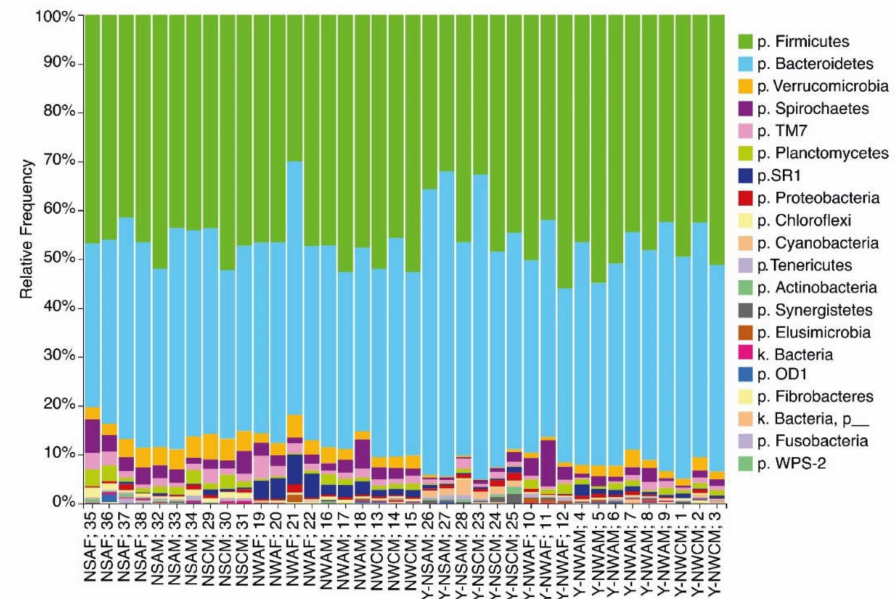
Figure 2. The taxonomic diversity (phylum level) of the ruminal microbial population in reindeer from Russian Arctic zones. Regions: N—Nenetski Autonomous District (AD); Y-N—Yamalo-Nenetski AD. Seasons: S—summer; W—winter. Age: A—adults; C—calves. Sex: M—male; F—female.